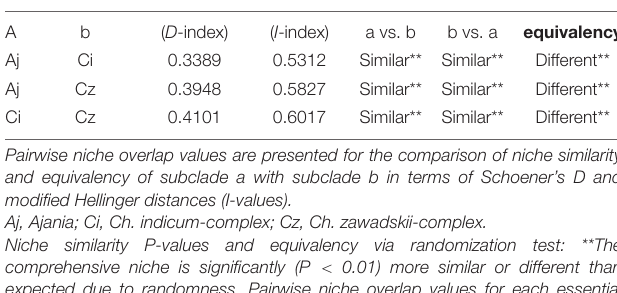
TABLE 5 | Ecological niche comparison among three subclades of the Chrysanthemum -group.